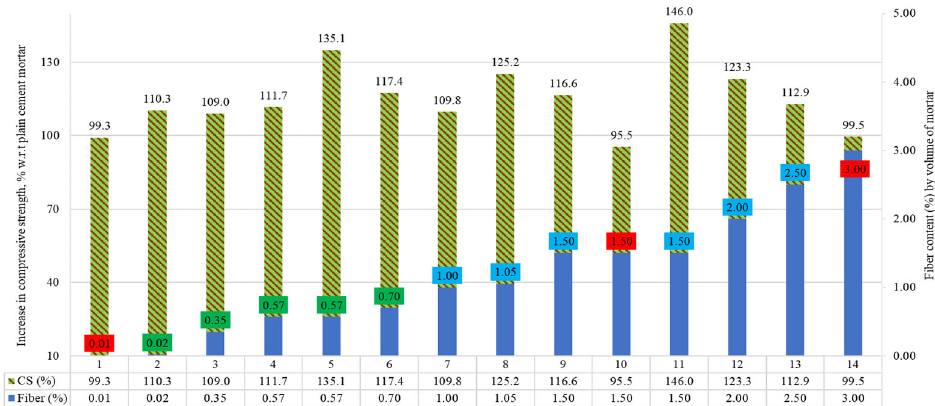
Figure 16. Percentage comparison of compressive strengths of mortars containing RSF by volume fraction.